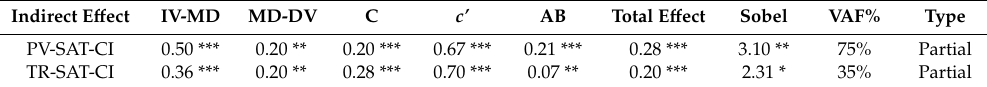
Table 7. Results of mediating e ff